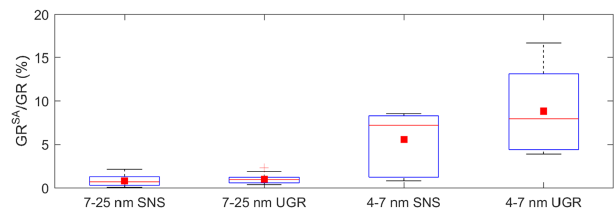
Figure 6. Box and whisker plot of sulfuric acid contribution to the total measured growth rate at SNS and UGR. The red line represents the median of the data, the square represents the mean of the data, and the lower and upper edges of the box represent the 25th and 75th percentiles of the data, respectively. The length of the whiskers represents the 1 . 5 × interquartile range, which includes 99.3% of the